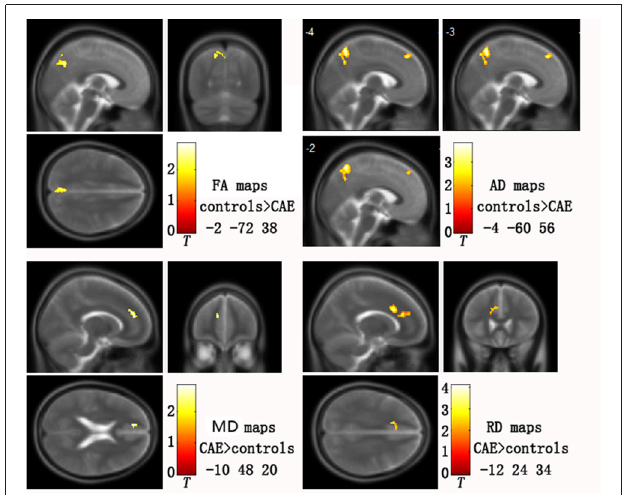
FIGURE 1 | Abnormal diffusion tensor imaging (DTI) parameters in childhood absence epilepsy (CAE) patients compared with healthy controls. Clusters are superimposed on the T2 templates in XJVIEW for fractional anisotropy (FA), mean diffusivity (MD), axial diffusivity (AD) and radial diffusivity (RD). Coordinates ( x, y, z ) show the slice on the sagittal top left ( x ), coronal top right ( y ) and horizontal bottom left ( z ) view of each template set. For AD maps, three sagittal slices are shown to better display the two clusters.